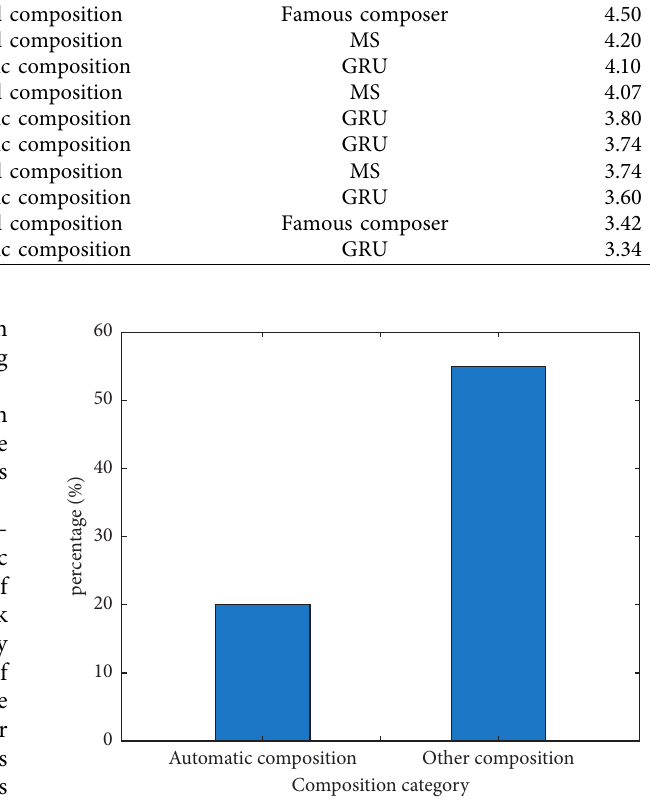
Figure 4: Percentage with a score of 3 or